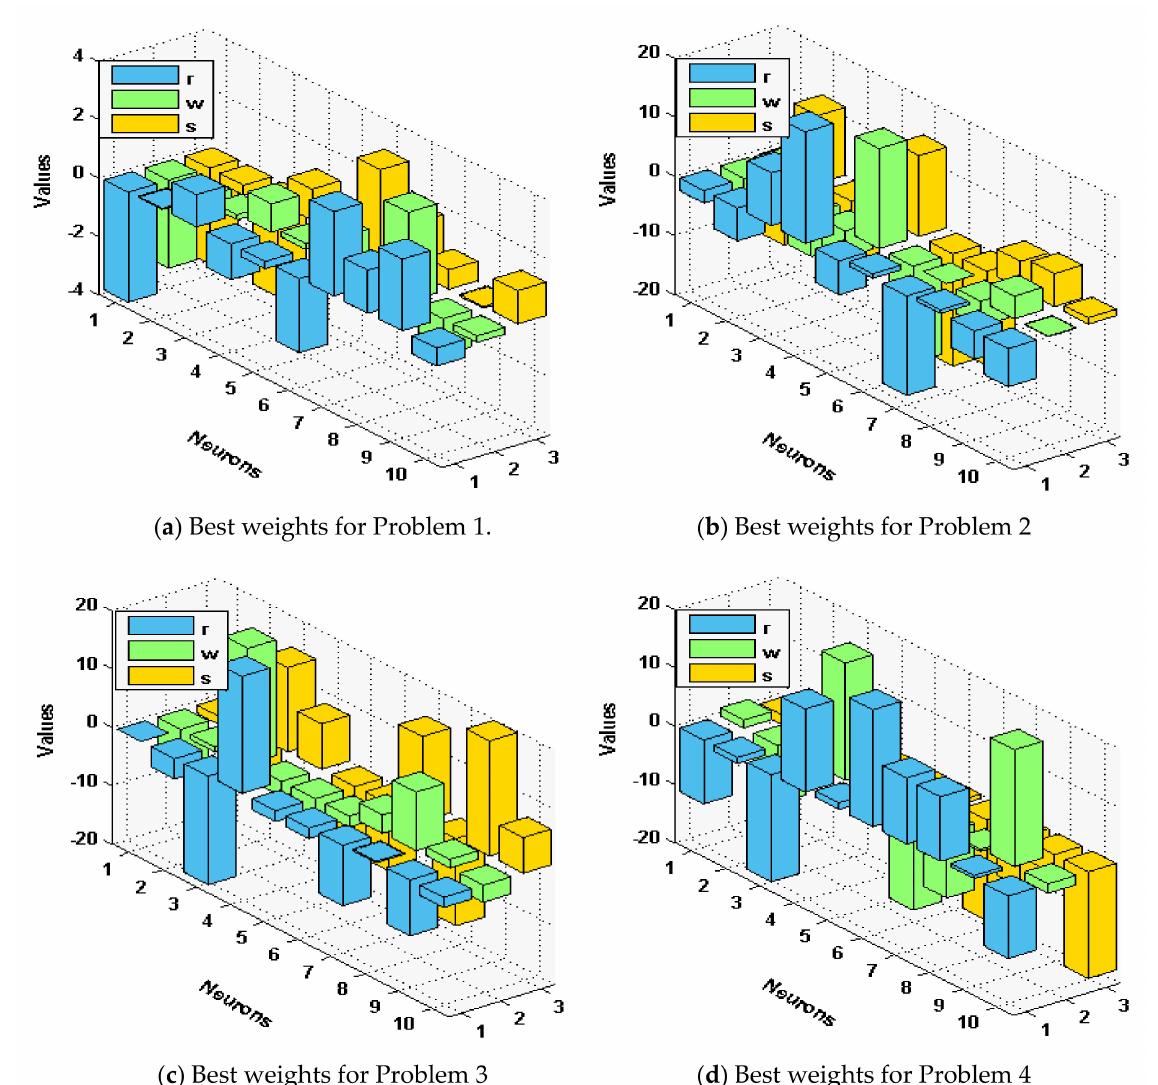
Figure 1. Best weights to solve the singular model of Lane–Emden